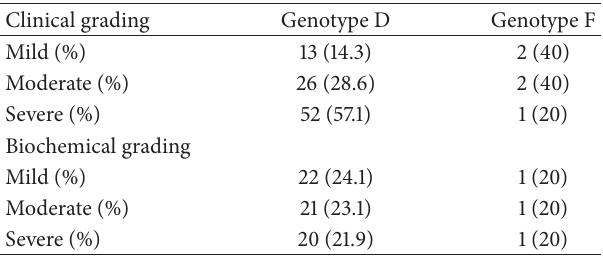
Table 1: Clinical and biochemical grading of severity of liver disease in different